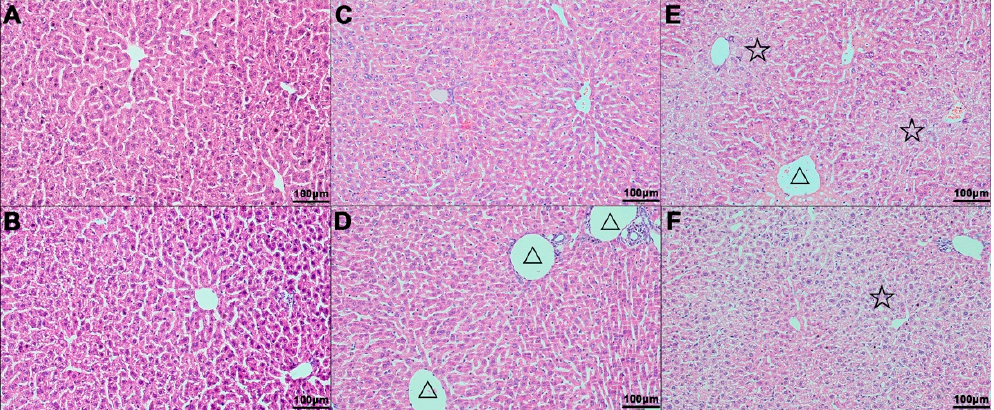
Figure 1. Hematoxylin and Eosin (H&E) staining of liver tissue after nutmeg exposure (200×). ( A , B ), control group; ( C , D ), low-dose group; ( E , F ), high-dose group.